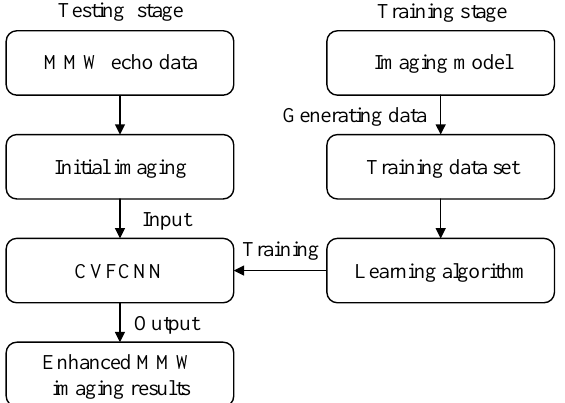
Figure 1. Framework of enhanced MMW 3-D imaging via the CVFCNN.